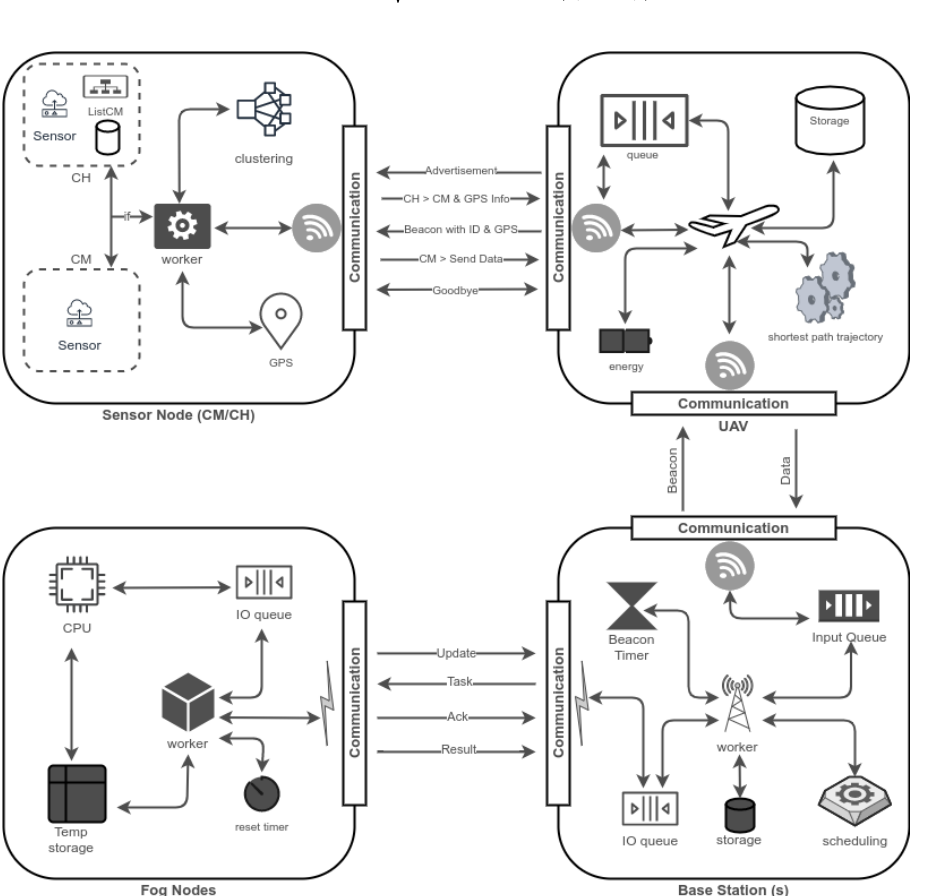
Figure 1. Working architecture—The working of different components of the system with sub- components. The sensors send data to UAV and UAV offload received data to a nearby base station that further schedules that to its fog members for further processing.